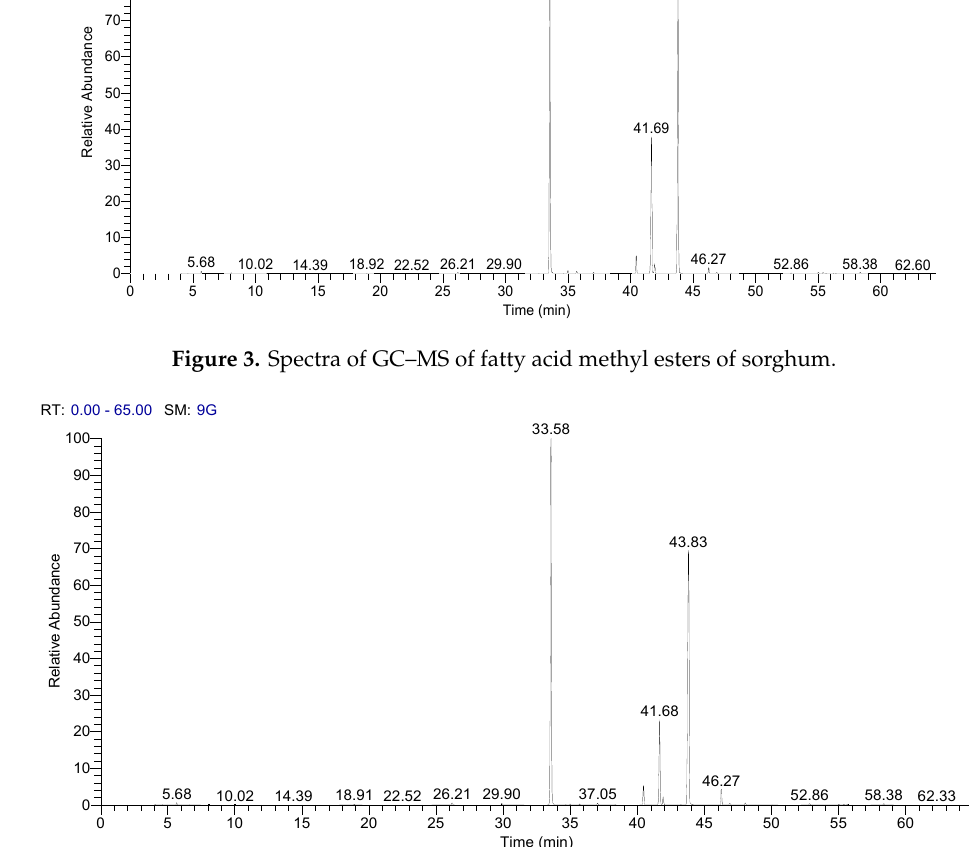
Table 6. Rheological characteristics of flour mixtures and wheat flour 100% Wheat Flour